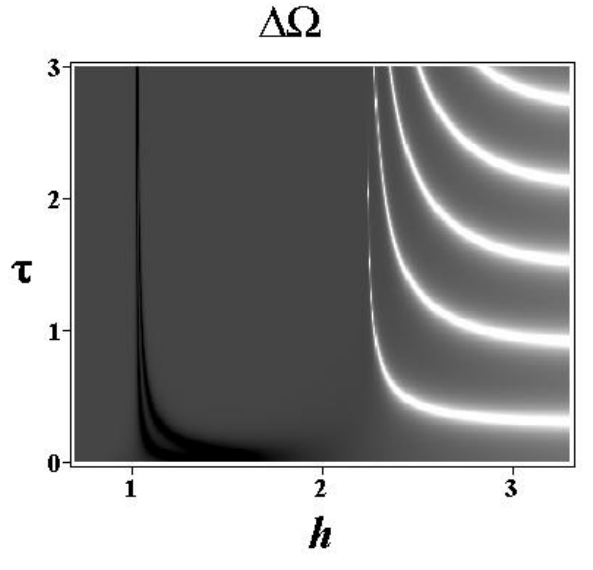
Figure 9. for S = 11 S = 11 S = 11 in Eqs. (65 and 66), shows in a gray scale map the behavior of the ∆Ω∆Ω∆Ω temporal evolution as a function of hhh . In this map the brightest tones represent the greatest amplitude values of the wave. It is noted that a barrier for these oscillating waves with high amplitudes occurs at depth h = h κ , 11 h = h κ , 11 h = h κ , 11 (see Eq. 68), and that after evanescently crosses this barrier, the wave becomes a hole soliton like. Moreover, this hole soliton reaches another barrier at h = h c , 11 h = h c , 11 h = h c , 11 (see Eq. 69) which forbids its propagation in shallow